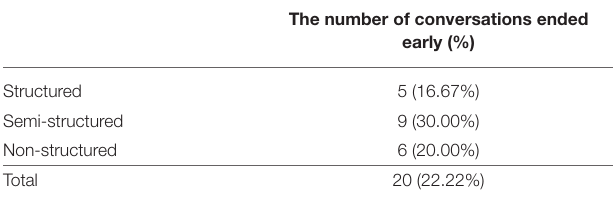
TABLE 7 | Task completion per CAVAA design.